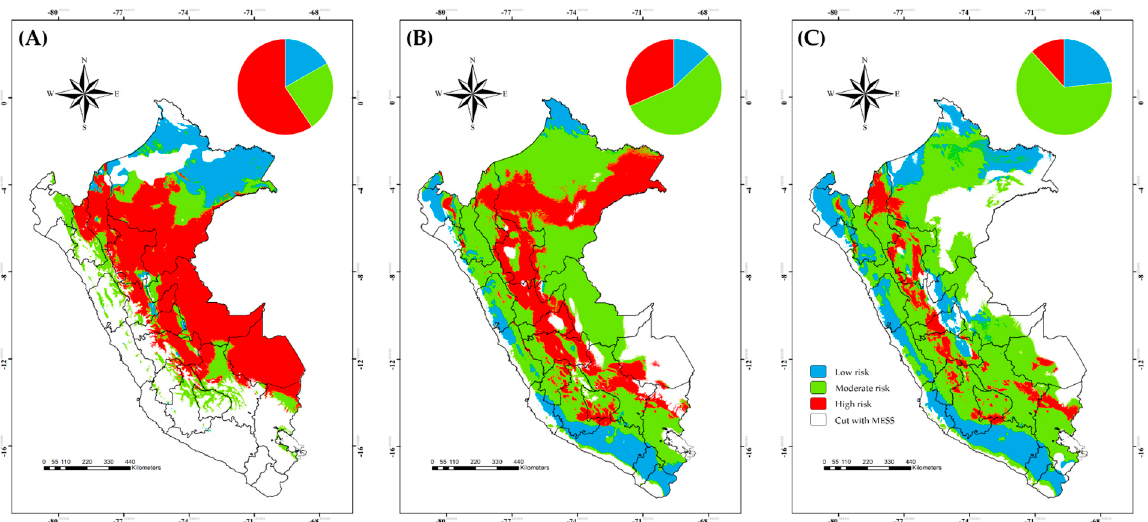
Figure 5. Risk map of bluetongue virus transmission by Culicoides insignis in Peru based on current ( A ) and future climate in two distinct scenarios ( B ) SSP126 and ( C ) SSP585. Colors represent different risk levels.